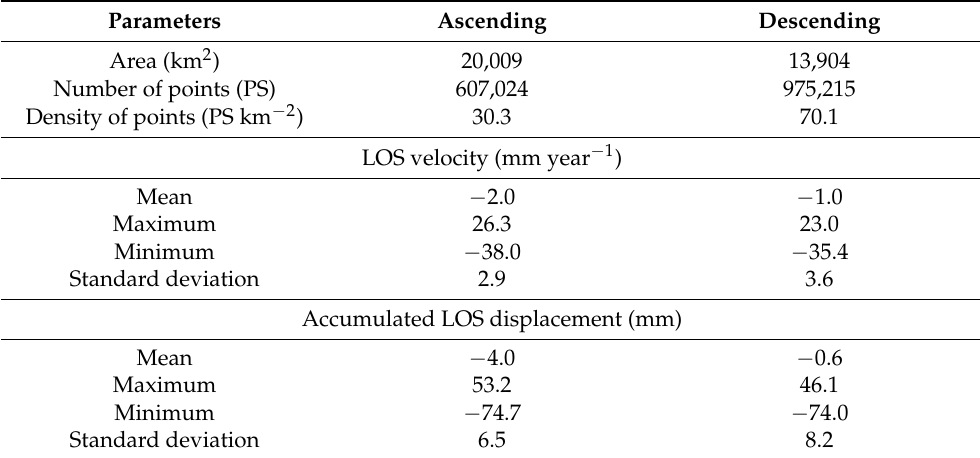
Maximum 53.2 Minimum − 74.7 − 74.0 Standard deviation 6.5